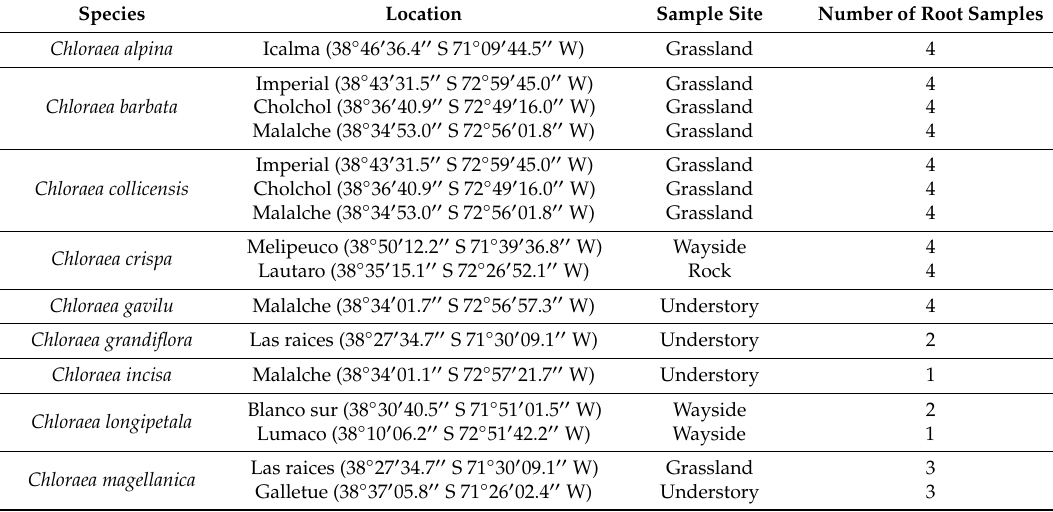
Table 1. List of plant and locations of orchids sampled in the